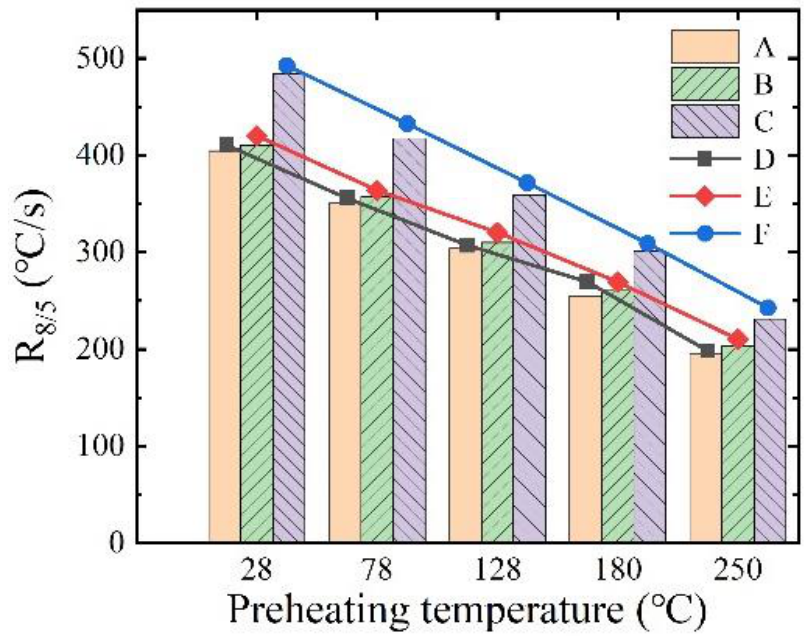
Figure 9. Calculated R 8/5 at the feature points under different preheating temperatures.